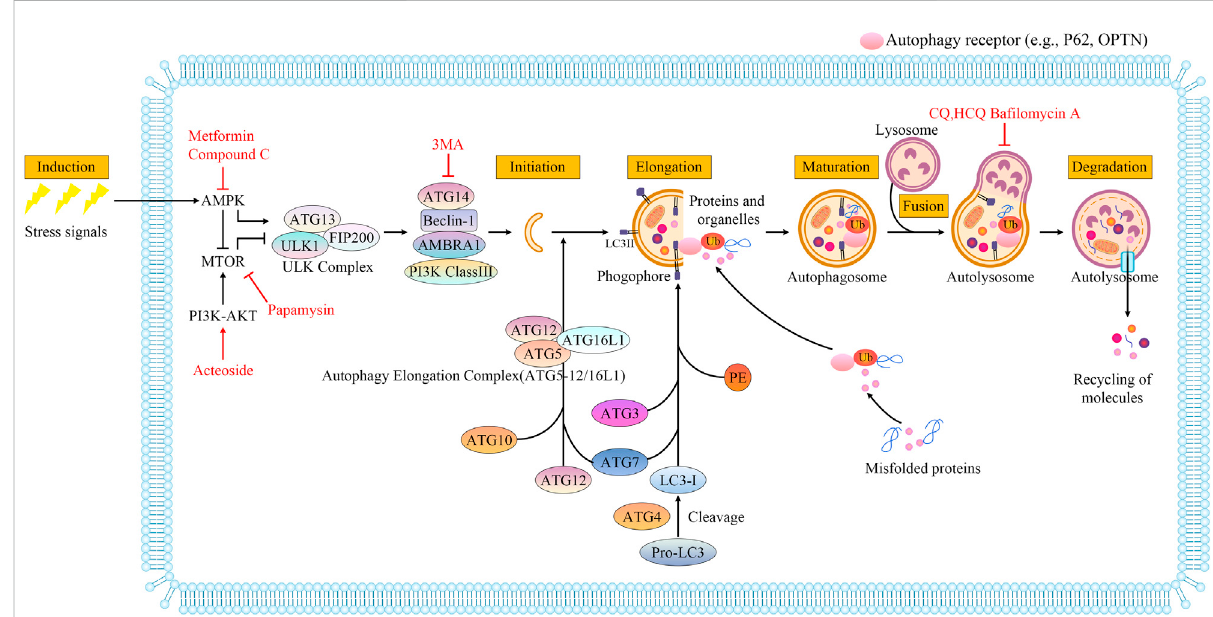
FIGURE 1 Molecular mechanisms during macroautophagy processes. Autophagy is a multistep process that includes induction, initiation, elongation, maturation, fusion with lysosomes, and degradation. The autophagy process is regulated by the mTOR and AMPK signaling pathways, which are responsible for monitoring the nutritional status of the cell. AMPK is an activator and mTOR acts as an inhibitor through the phosphorylation of ULK1 at distinct residues. The ULK1-containing initiation complex triggers phagophore formation by phosphorylating components of the class III Ptdlns3K nucleation complex. During autophagosome biogenesis, after ATG5 binds ATG12, the ATG5-ATG12 conjugate binds to ATG16L1 to generate the autophagy elongation complex (ATG5-12/16L1), which regulates lipidation of LC3. LC3, a ubiquitin-like modi fi er, is cleaved by the protease ATG4 to form LC3-I. LC3-I conjugates with PE to form LC3-II, which incorporates into autophagosomal membranes and is critical for the formation ofautophagosomes. Autophagy receptor(e.g.,P62,OPTN)servesasalinkbetweenLC3andubiquitinated proteinsororganellestargeted for degradation. Autophagosomes are eventually fused with lysosomes to form autolysosomes. The cargos in autolysosomes are degraded by lysosomal enzymes, and nutrients and metabolites are recycled. Metformin induces autophagy by targeting AMPK. MTOR signals can be inhibited directly by rapamycin. PI3K and AKT are elevated by acteoside. 3-Methyladenine(3-MA) can speci fi cally block autophagosome formation. BAFA1 inhibits the acidi fi cation of the autolysosome by blocking the V-ATPase while chloroquine (CQ) and 3-hydroxychloroquine (HCQ) impair the maturation of autolysosomes. Drugs are depicted in red